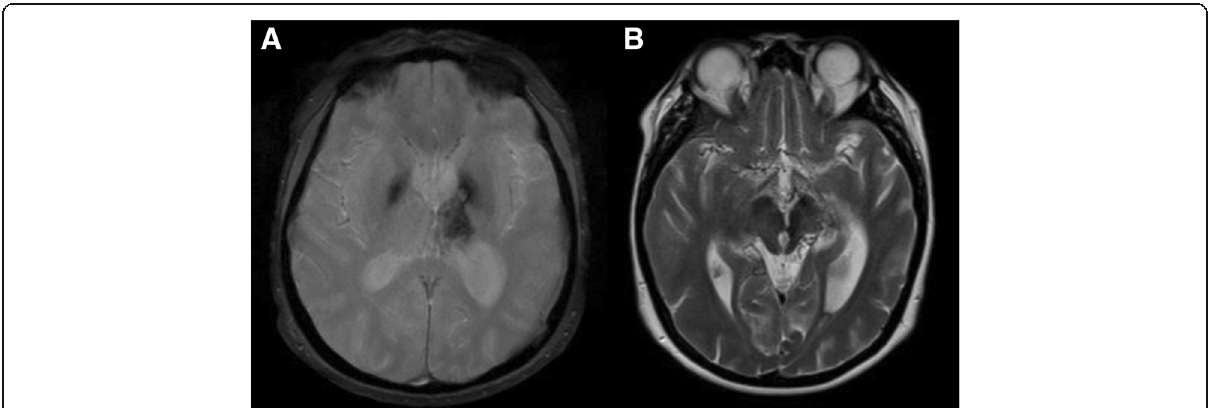
Fig. 16 Axial T2* ( a ) and T2/TSE ( b ) of a 46-year-old patient with Down syndrome, presenting signs of an old hemorrhagic stroke involving the left thalamic-capsular area. Note also the prominent flow voids from collateral vessels involving the basal cisterns and horizontal segments of the